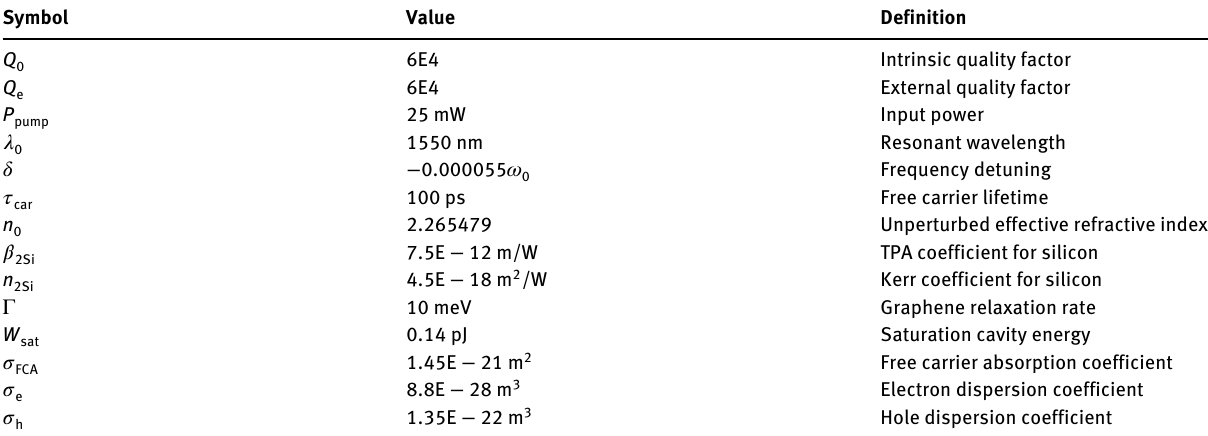
Table 2: Simulation parameters.